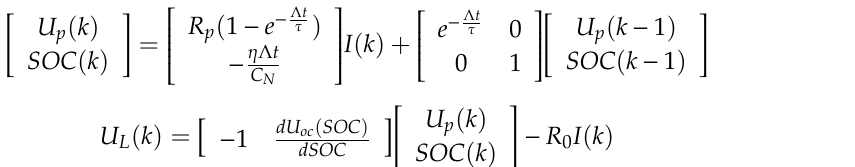
Figure 2. The Thevenin equivalent circuit.